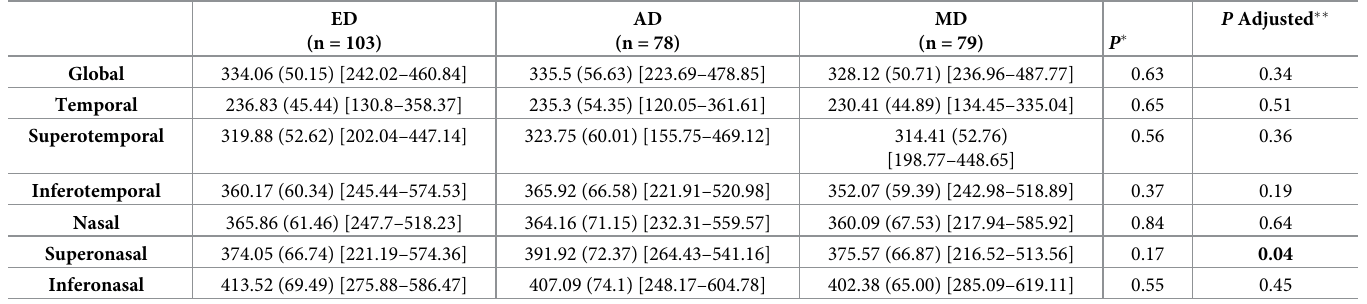
Fig 3. Graphs showing (A) minimum rim width (MRW) and (B) peripapillary retinal nerve fiber layer thickness (RNFLT) profiles for each race . ED: European Descent; AD: African Descent; MD: Mixed Descent. T: temporal; S: superior; N: nasal; I: inferior. https://doi.org/10.1371/journal.pone.0206887.g003 Mean global RNFLT was thinner in ED (P = 0.01), but this difference was statistically elimi- nated after adjusting for BMO area and age (P = 0.07, Table 3 ). In regional analysis, however, after adjusting for BMO area and age, both MRW and RNFLT were greater in AD in the super- onasal sector (P = 0.04, P < 0.001, respectively) while RNFLT was greater among AD and MD in the inferonasal sector (P = 0.009, Tables 2 and 3 ). Table 2. Comparison of global and sectorial minimum rim width (MRW) measurements by